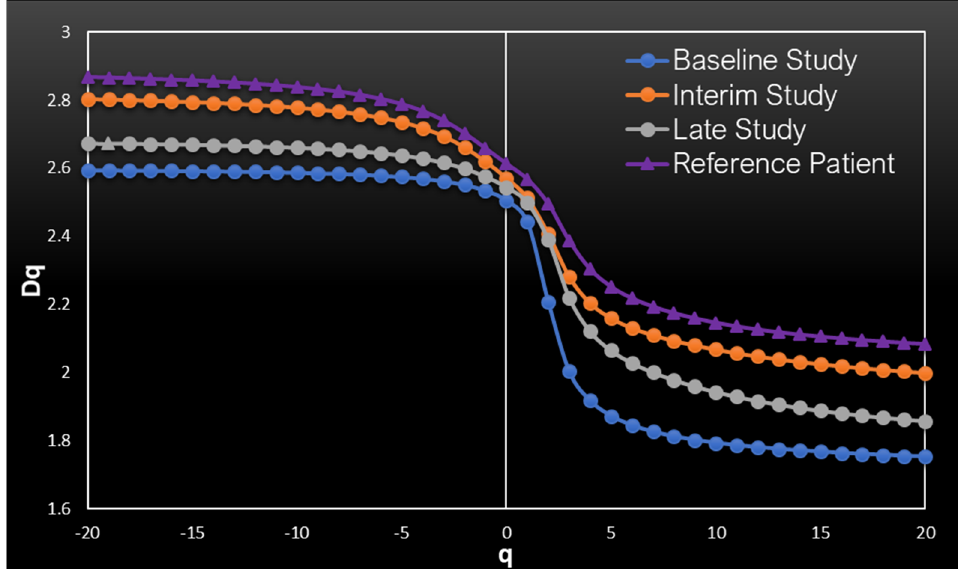
Figure A3. Typical MFS spectrum of patient with PMR. The blue line corresponds to the baseline study of patient P10, the orange line corresponds to the interim study and the gray line to the final study of the same patient. For comparison, the purple line representing healthy control H5 is also depicted.